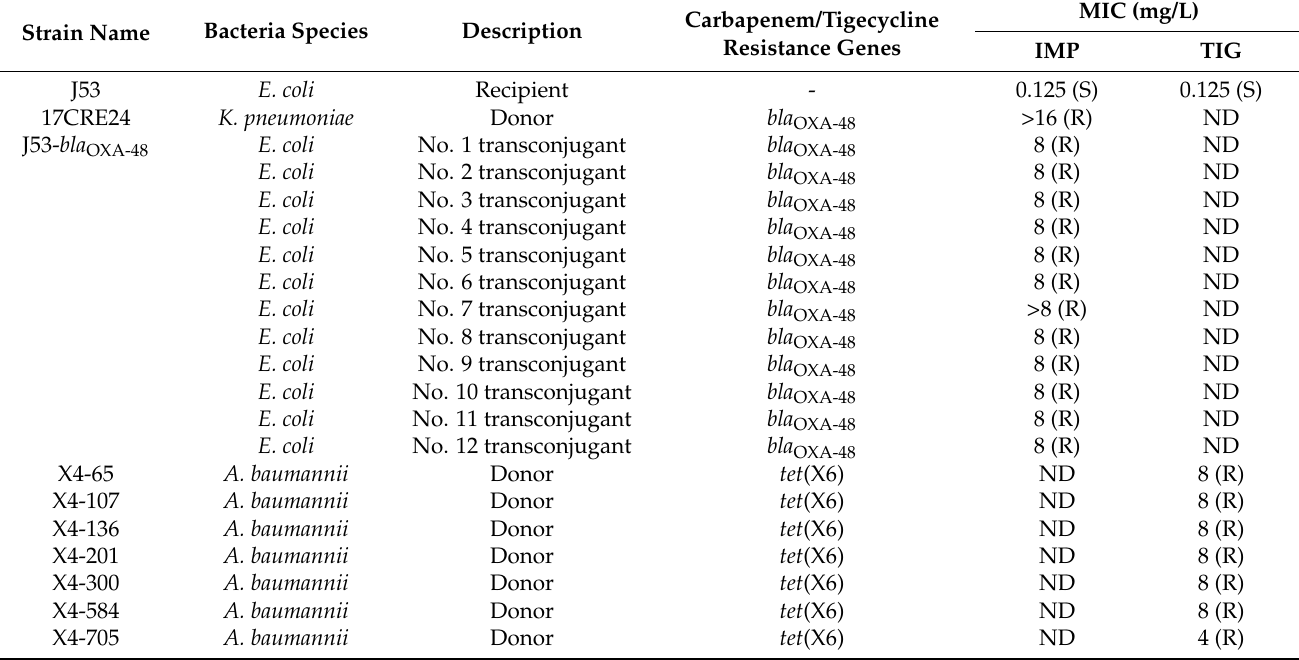
Table 1. MIC values of carbapenem-resistant Klebsiella pneumoniae 17CRE24, seven tigecycline-resistant A. baumannii strains, the recipient E. coli J53, and the